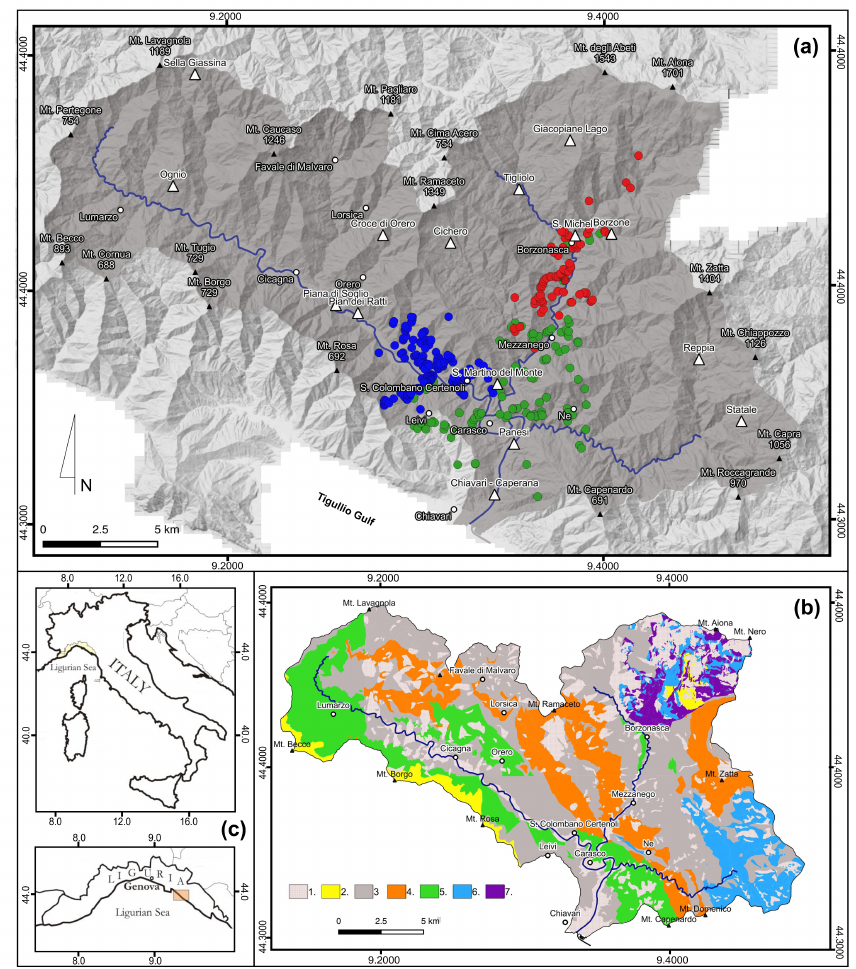
Figure 1. (a) Geography and morphology of the Entella River basin and the surrounding areas. White triangles show location of rain gauges. Dots show locations of shallow landslides for the 23–24 November 2002 (blue), the 21–22 October 2013 (red), and the 10–11 November 2014 (green) rainfall events. (b) Simplified geological map for the Entella River: 1 – quaternary deposit; 2 – marly limestone, calcareous or clayey marl; 3 – shale, shale with interlayered siltstone and limestone; 4 – sandstone; 5 – marl and silty marl; 6 – ophiolite; 7 – chaotic complex. (c) Location